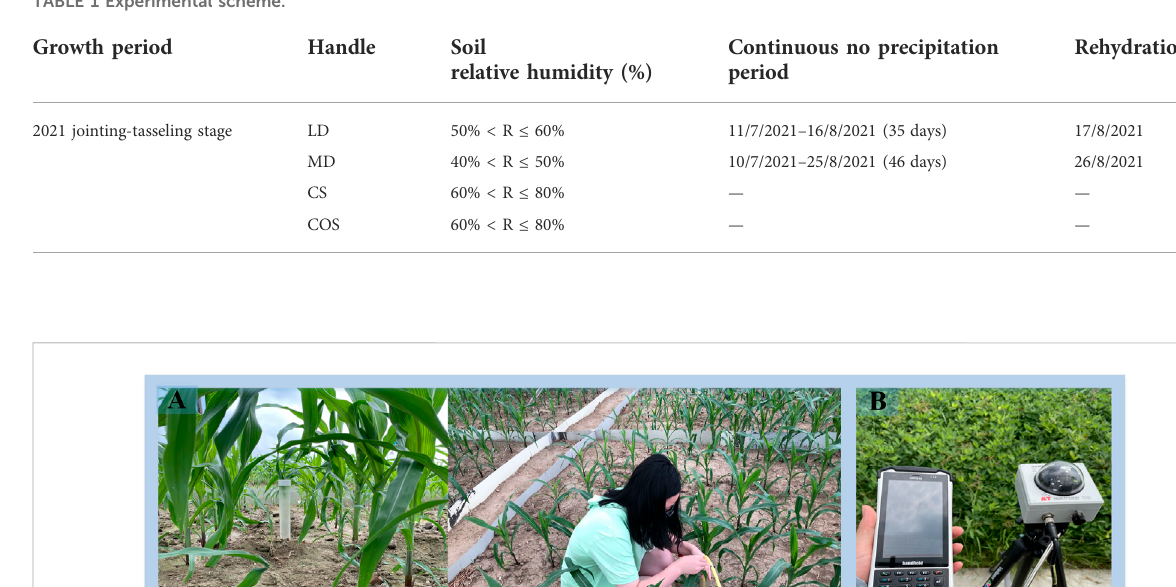
TABLE 1 Experimental scheme.